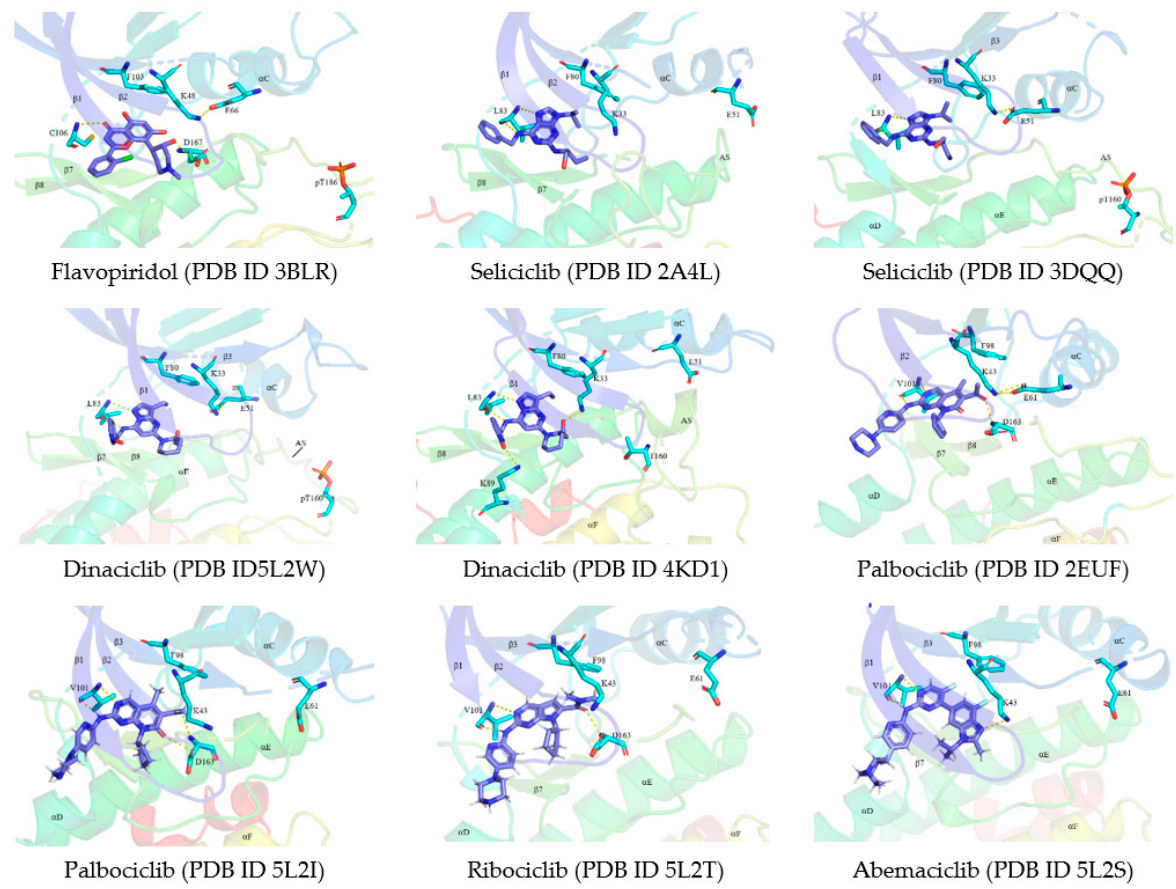
Figure 5. Drug–enzyme complexes and corresponding PDB ID. The drug’s carbon atoms and enzymes are depicted by blue and cyan, respectively, while polar bonds are represented by dashed lines.